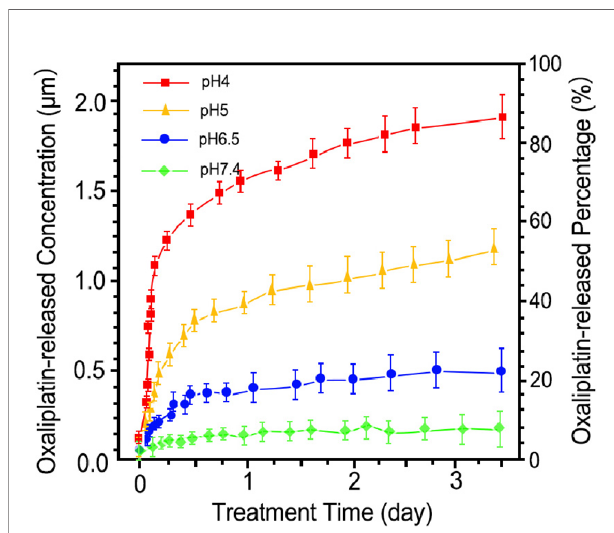
FIGURE 2 | Drug release pattern of Oxaliplatin/HCE6-MSNs. The drug release analysis was performed at pH 4, pH 5, pH 6.5, and pH